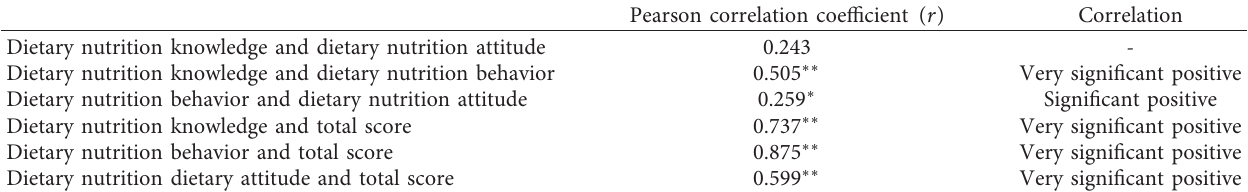
Table 3: Summary of correlation analysis between dietary nutrition knowledge-attitude-behavior and total score. Pearson correlation coefficient ( r ) Dietary nutrition knowledge and dietary nutrition attitude Dietary nutrition knowledge and dietary nutrition behavior